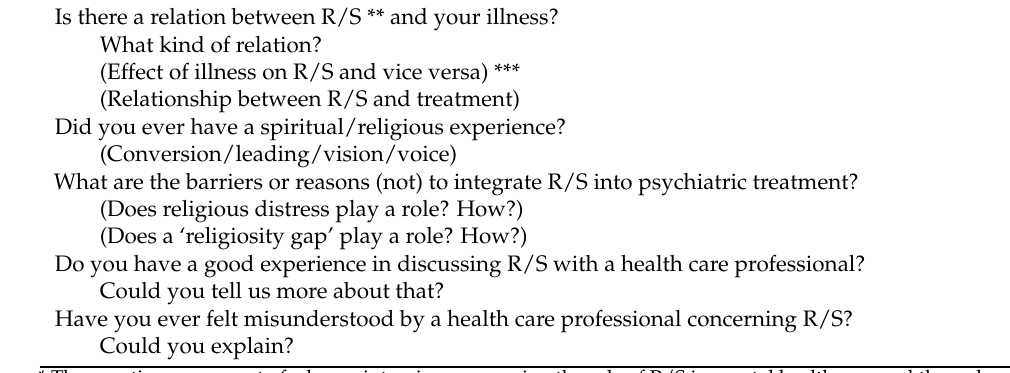
Table 1. Interview questions related to the topic of the current study